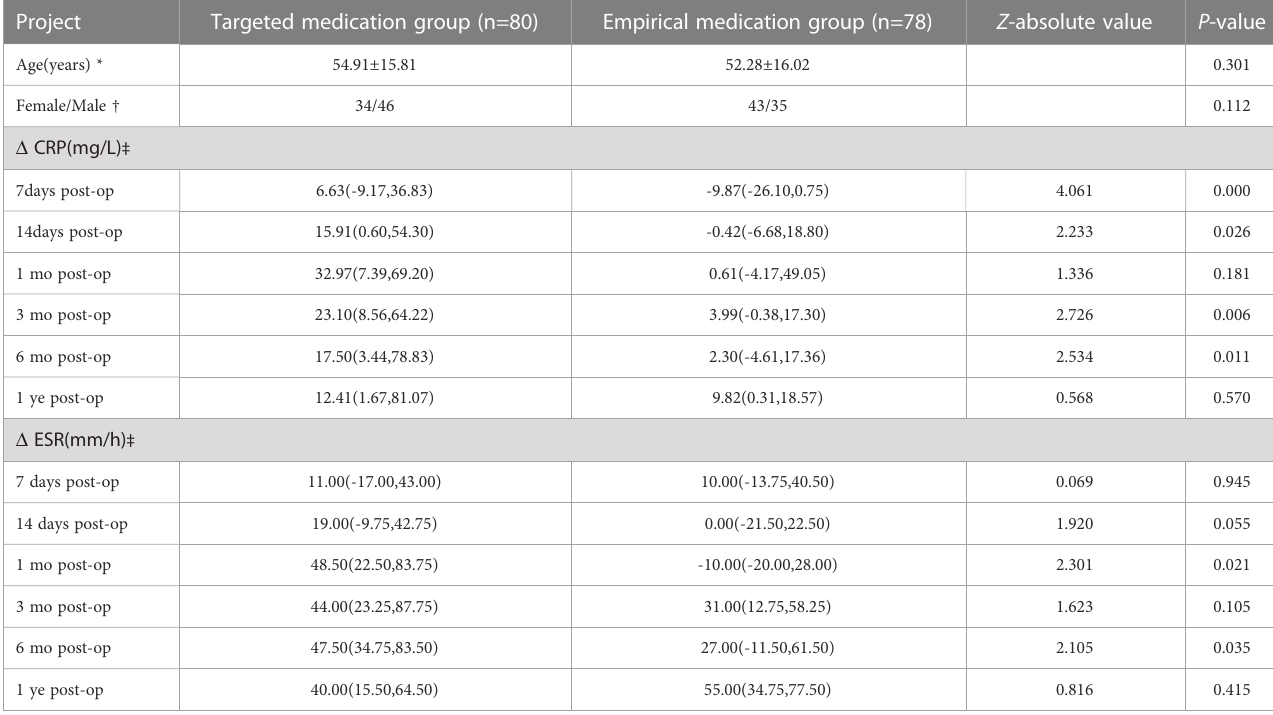
TABLE 1 The comparison of the difference of D CRP (pre-op CRP-post-op CRP) and D ESR (pre-op ESR-post-op ESR) [ M ( P 25 , P 75 )] between two groups at different follow-up times.